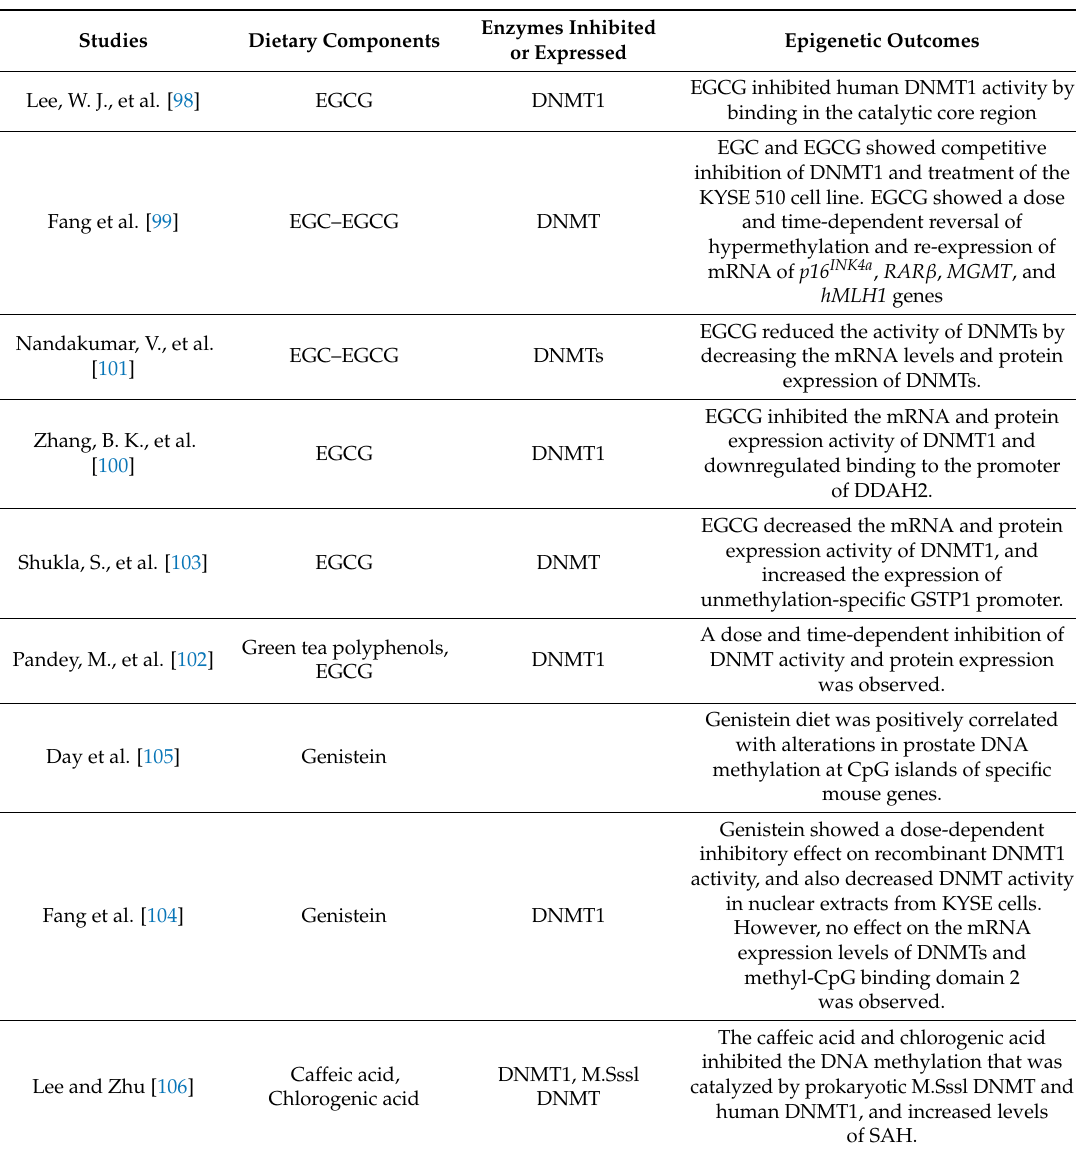
Table 1. Studies that have evaluated the interaction between bioactive dietary components 1